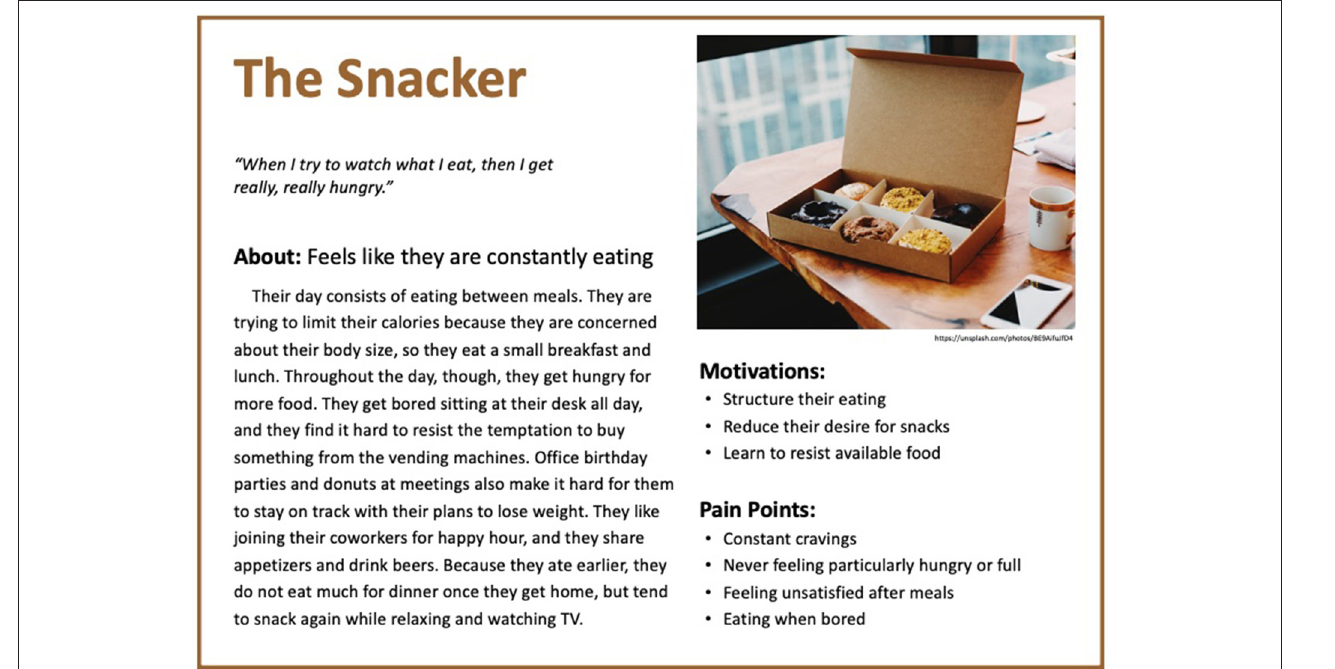
FIGURE 1 | Persona 1: The Snacker.